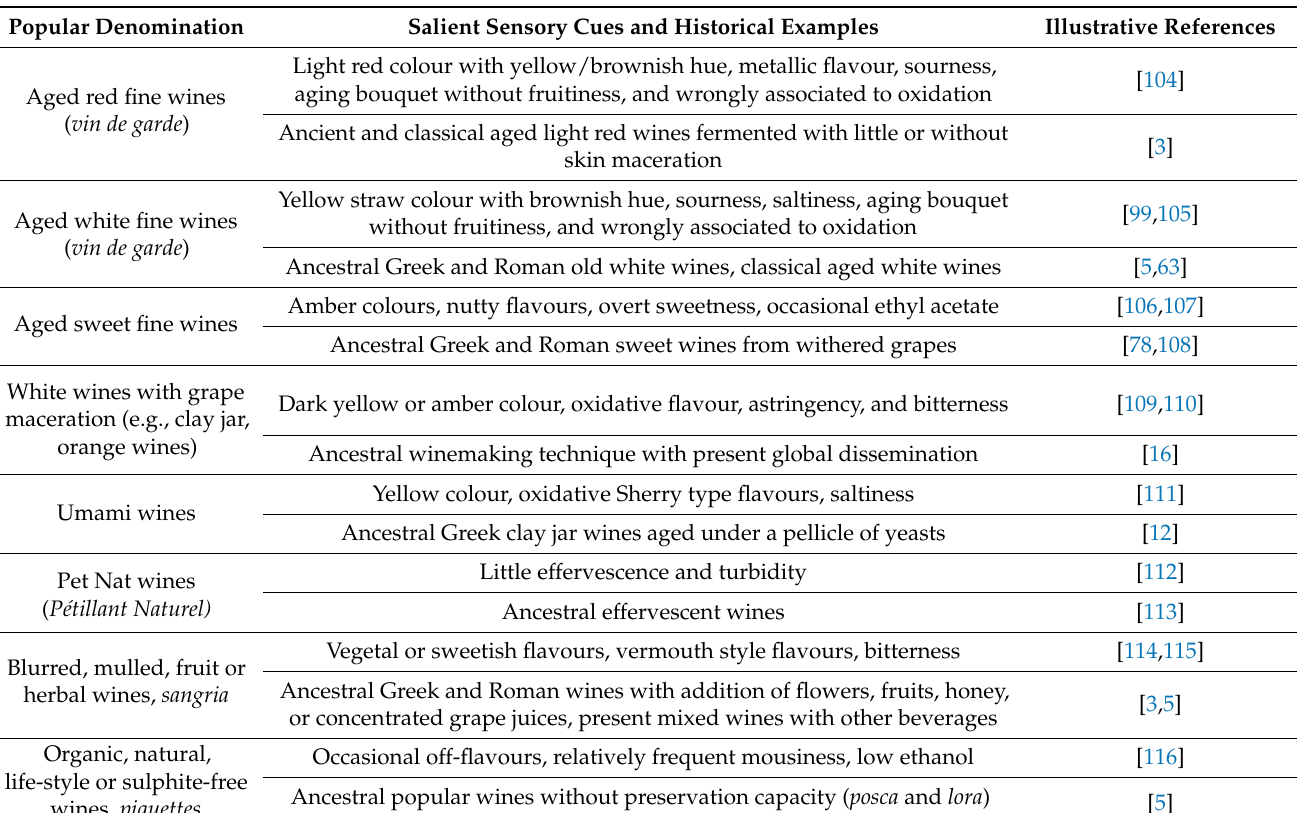
Table 2. Types of ancient or classical wines with salient sensory features and respective historical